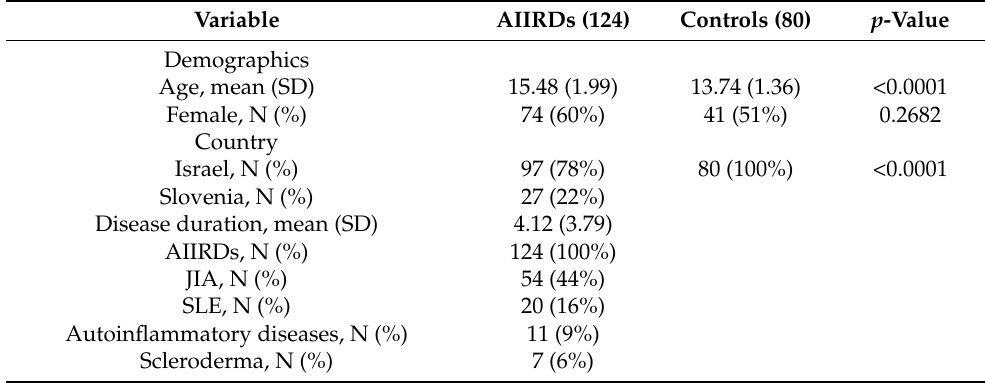
Table 1. Baseline characteristics of adolescents with AIIRDs and